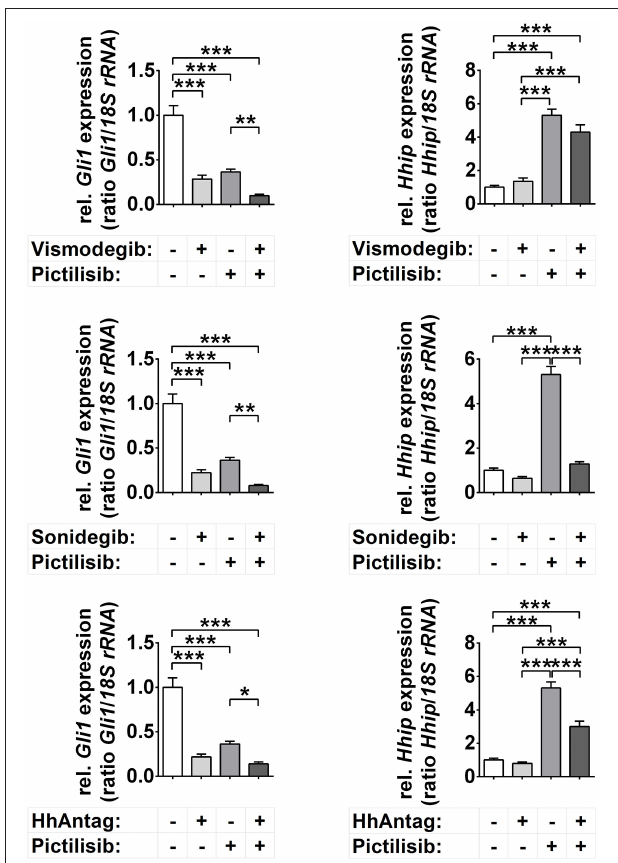
FIGURE 1 | Effects of Smo and/or Pi3k inhibition on Hh target gene expression. Gli1 and Hhip expression in cells treated for 48h with 10 µ M vismodegib, 10 µ M sonidegib, 10 µ M HhAntag or 5 µ M pictilisib. Bars represent the mean + s.e. of three independent experiments measured